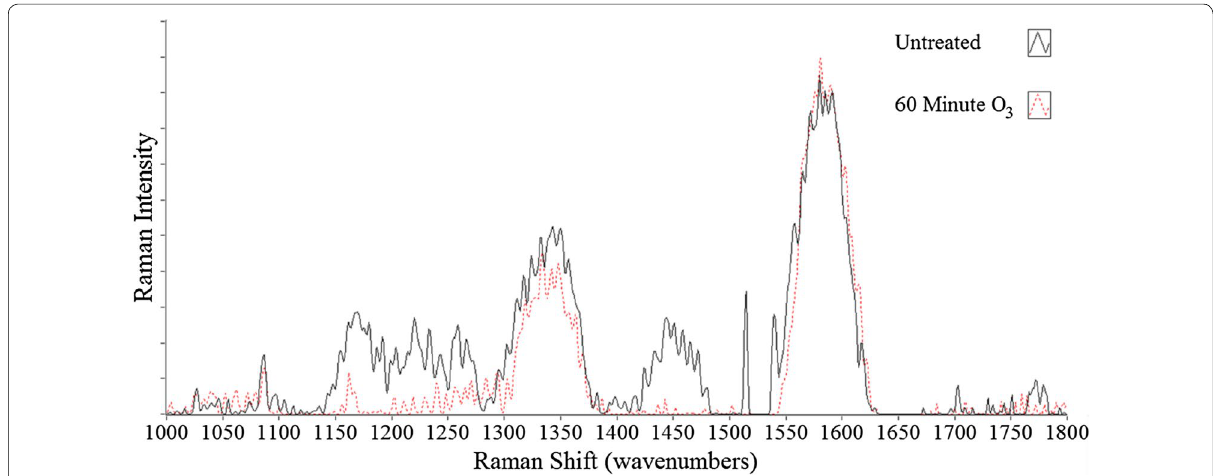
Fig. 4 Raman spectra of untreated biochar and biochar samples treated with 60 min of